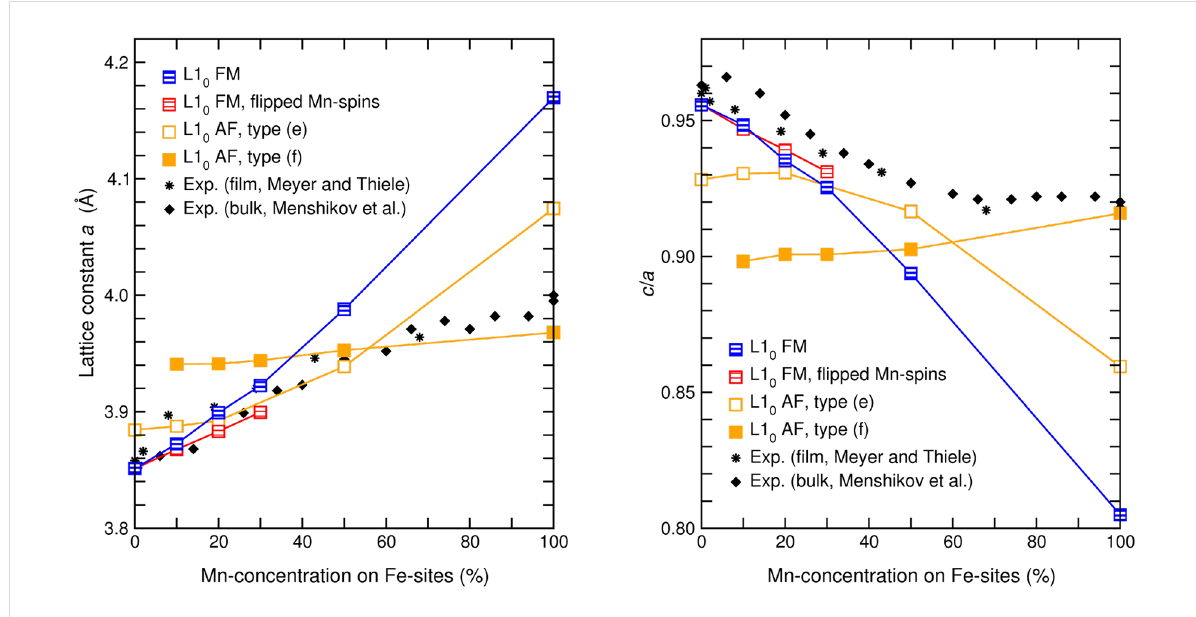
Figure 3: Lattice constant (left panel) and c / a ratio (right panel) of ternary 561-atom Fe–Mn–Pt clusters with different morphologies and magnetic structures as a function of the composition. Symbols as in Figure 2. The lattice parameters were obtained by averaging the interlayer distances in the respective directions. The values are compared with the experimental XRD data obtained at room temperature by Meyer and Thiele [74] for thin films (black stars) and Menshikov et al. [73] for bulk powder samples (black